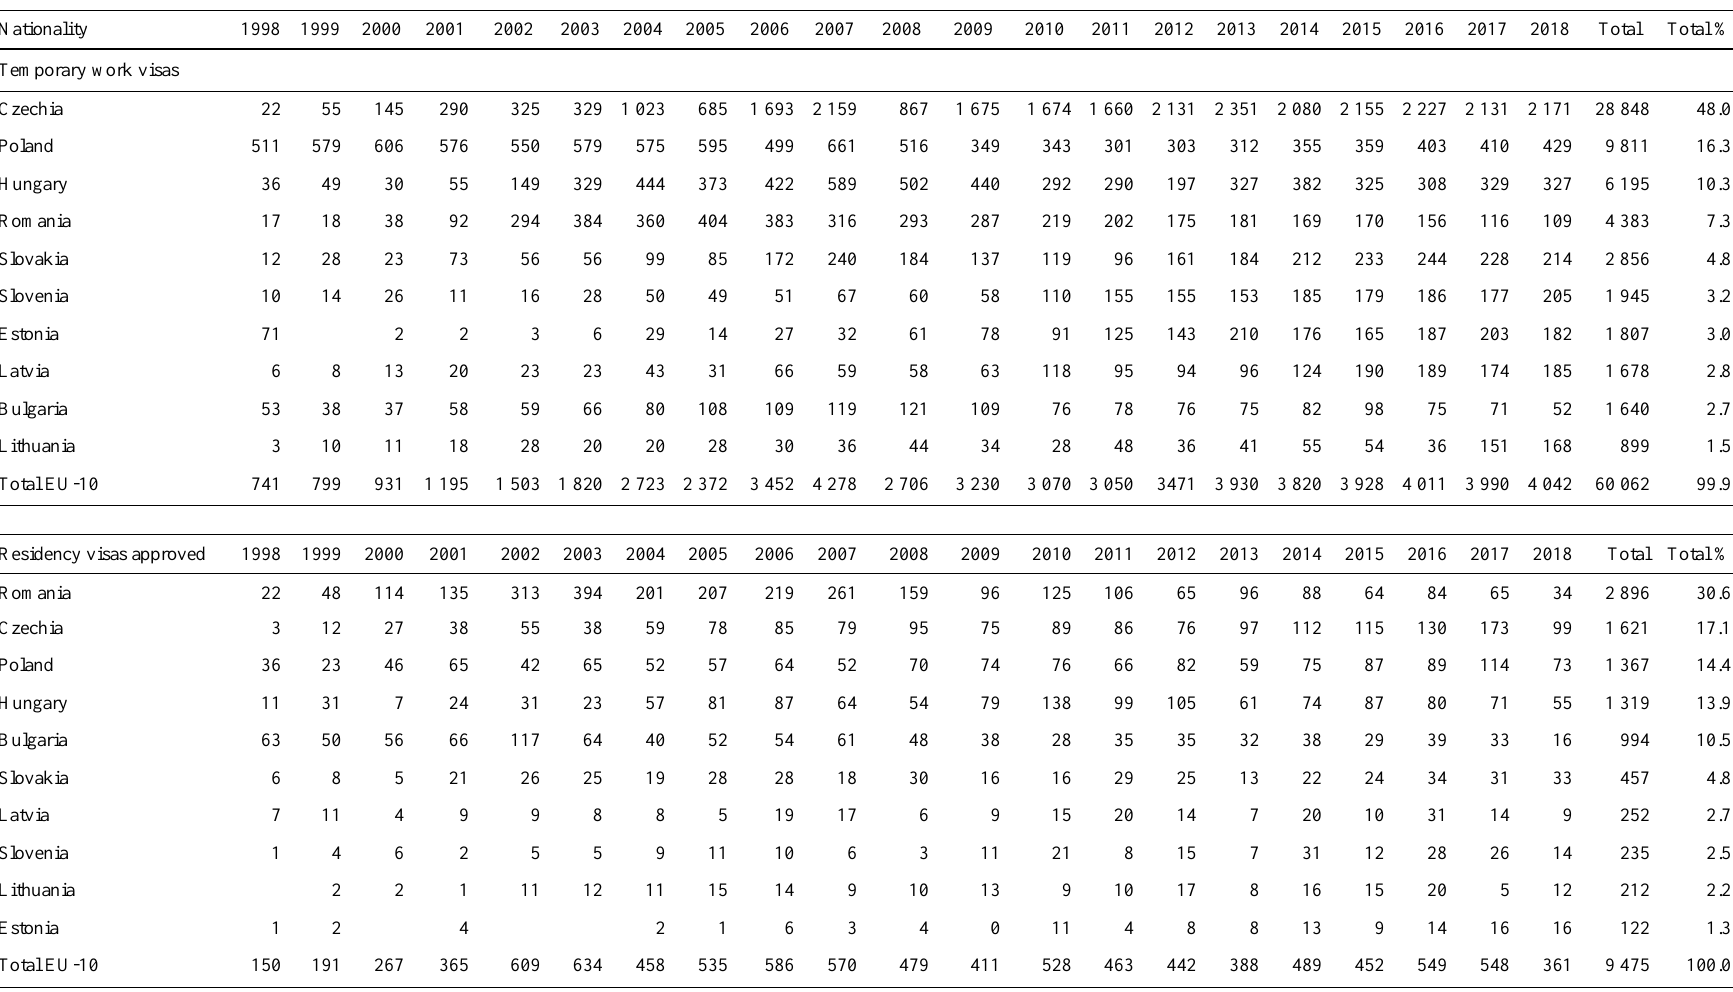
Table 3. Temporary work and residency visas approved by nationality, CEE EU-10 countries, 1998–2018 (end of June